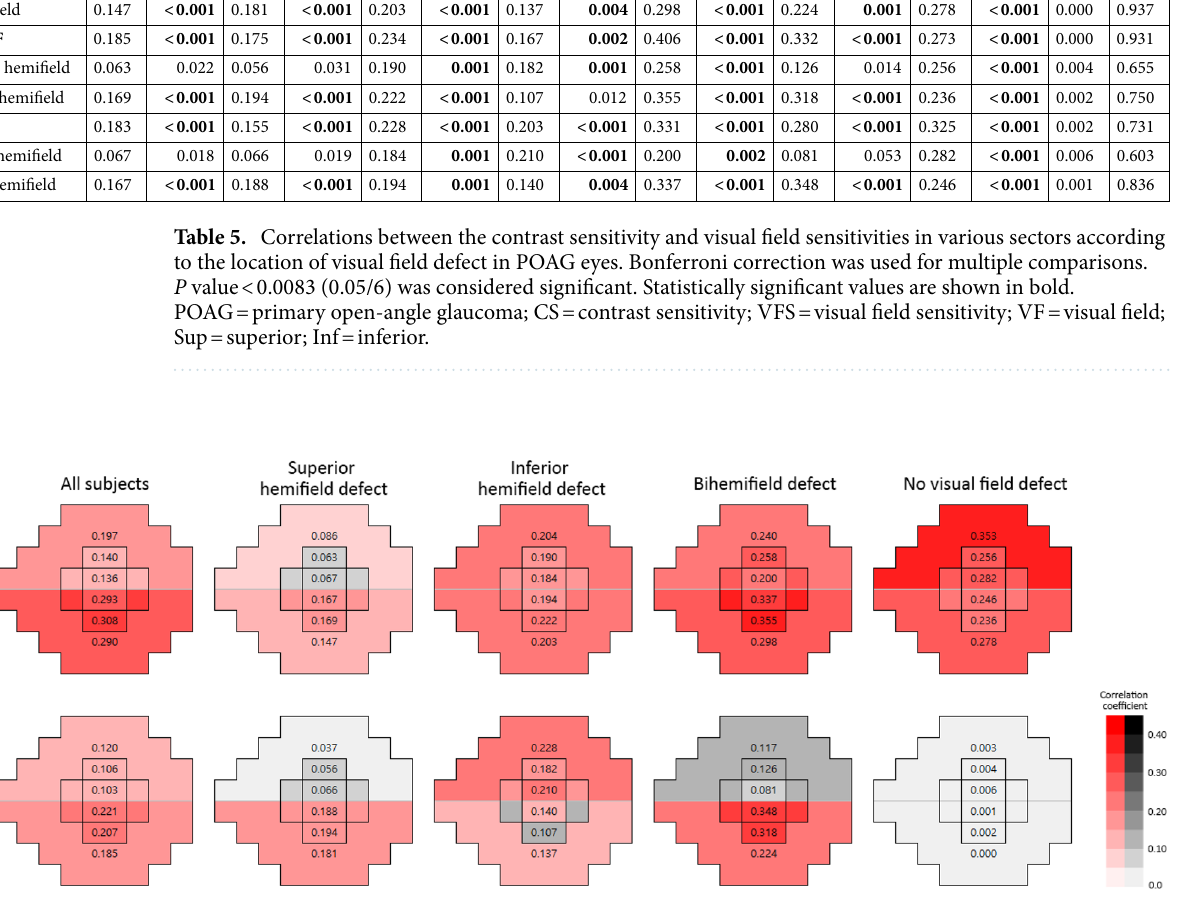
Figure 1. Correlations between contrast sensitivity and visual field sensitivities in various sectors according to the location of visual field defect. Red and gray scales were determined based on the correlation coefficient (the number in each sector), with red scale indicating statistically significant correlations. CS = contrast